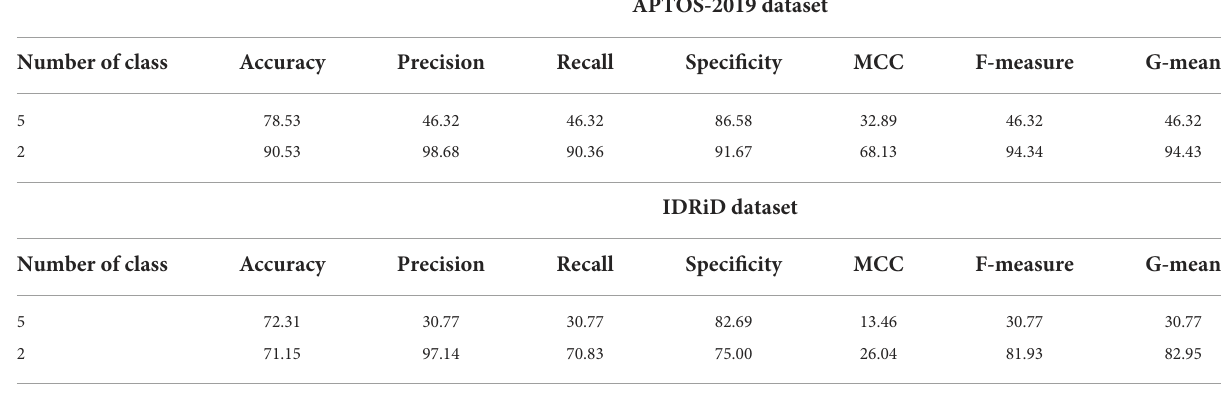
TABLE 8 The highest experiments outcomes of the classification and detection for NN approach using APTOS-2019 and IDRiD